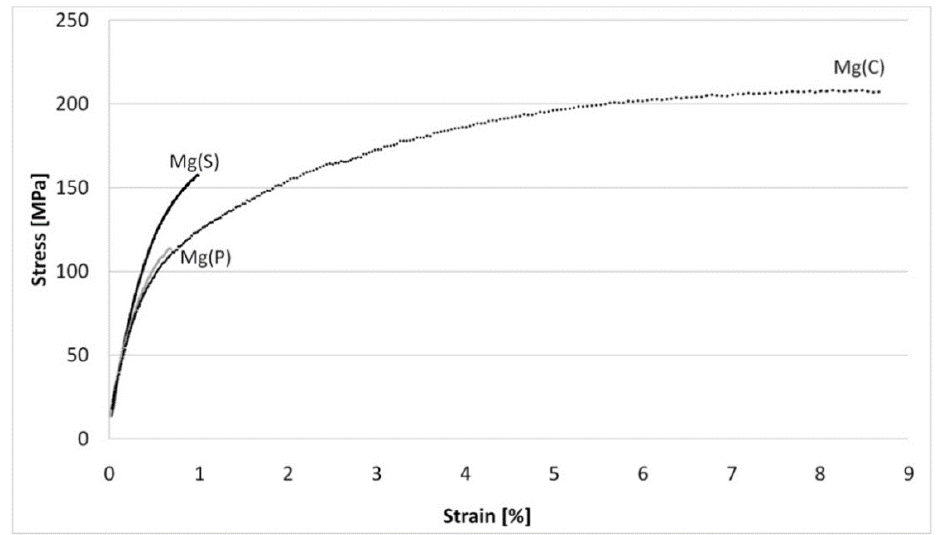
Figure 9. Representative curves obtained in tensile strength tests for magnesium rods extruded by the KOBO method from cold compacted magnesium powder — Mg(P), sintered magnesium powder — Mg(S), and cast magnesium — Mg(C).